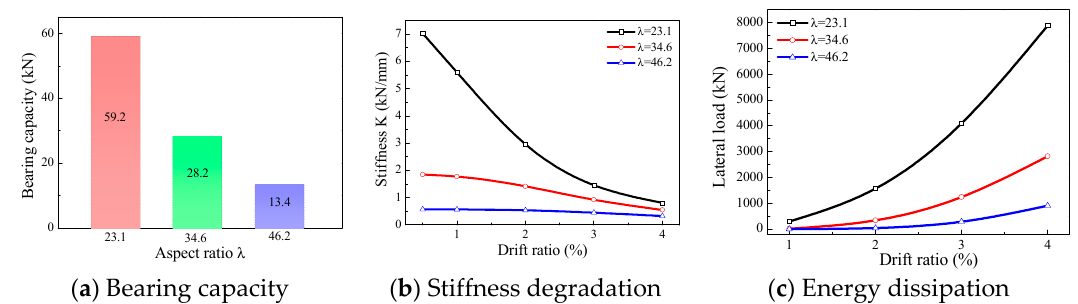
Figure 16. The e ff ect of the length–diameter ratio. Figure 16. The effect of the length–diameter